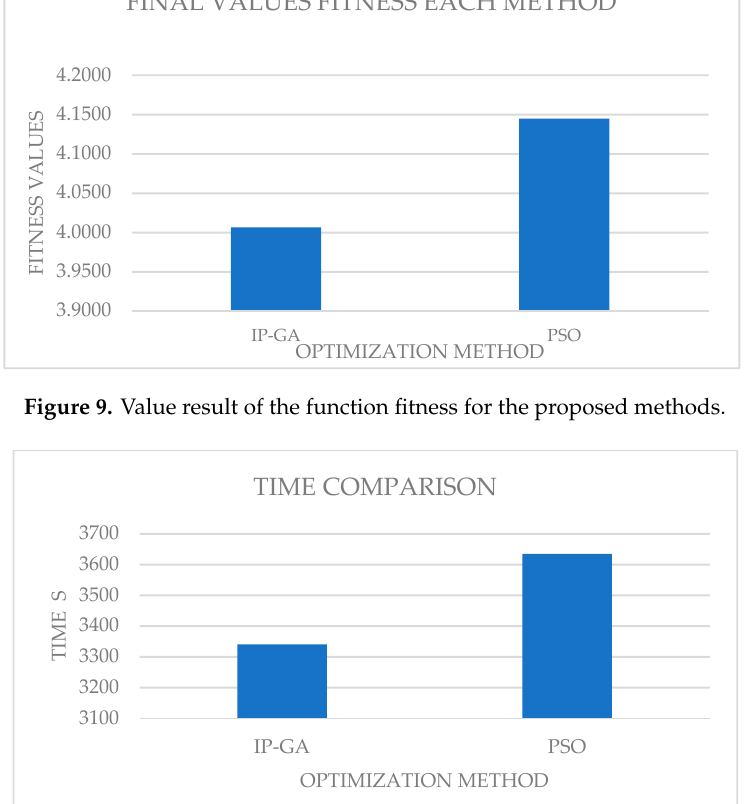
Figure 10. Runtimes for the proposed methods.